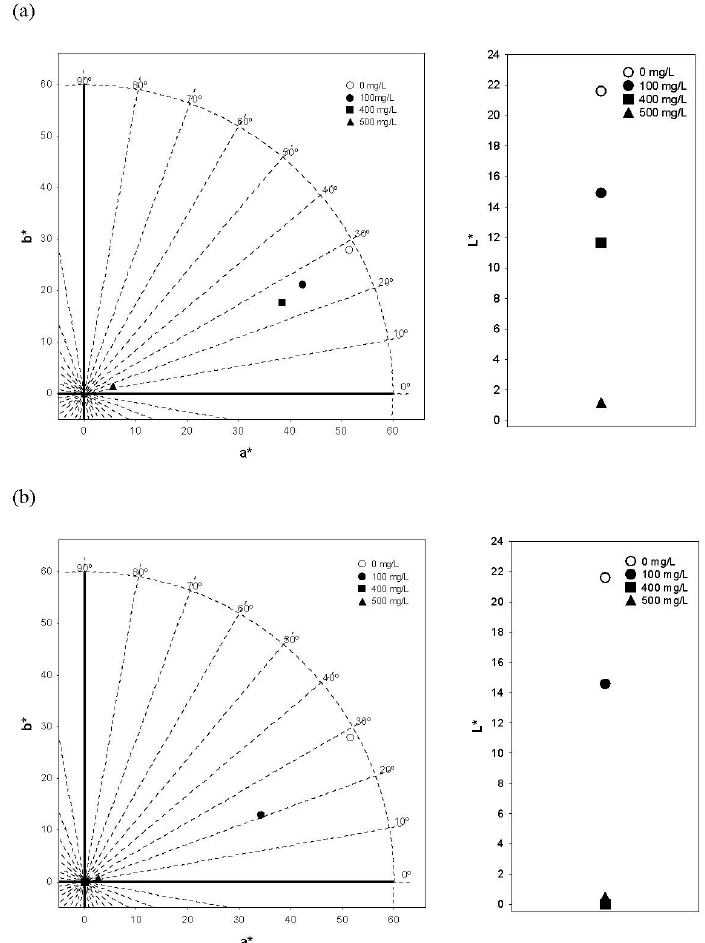
Figure 1. (a*b*) Color diagram and lightness (L*) of the control solution and the model solutions with di ff erent TPC from ( a ) American (AOW) and ( b ) Ukrainian (UOW) shavings.